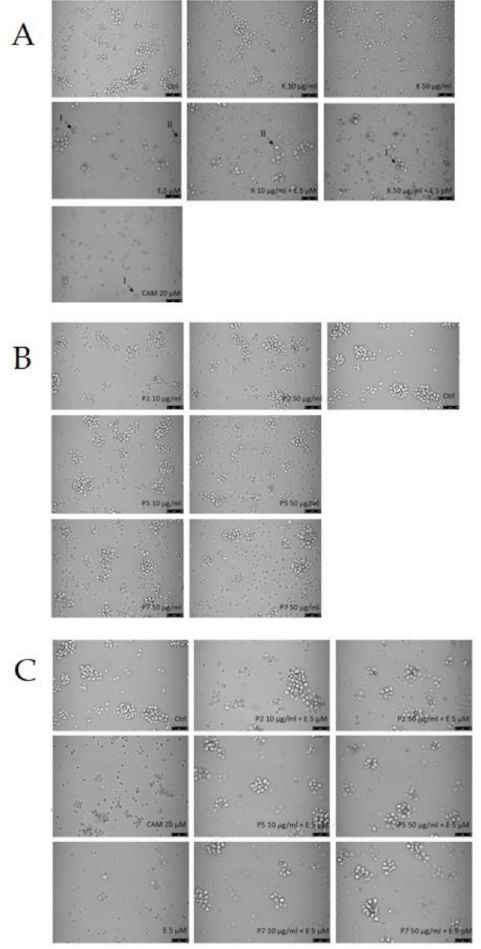
Figure 3. Morphological changes of human promyelocytic leukemia (HL-60) cells as examined by phase-contrast microscopy (magnification, × 200) after incubation with kaempferol and etoposide ( A ), kaempferol derivatives ( B ) or kaempferol derivatives and etoposide ( C ). Cells with fragmented nuclei (I) and enlarged cells